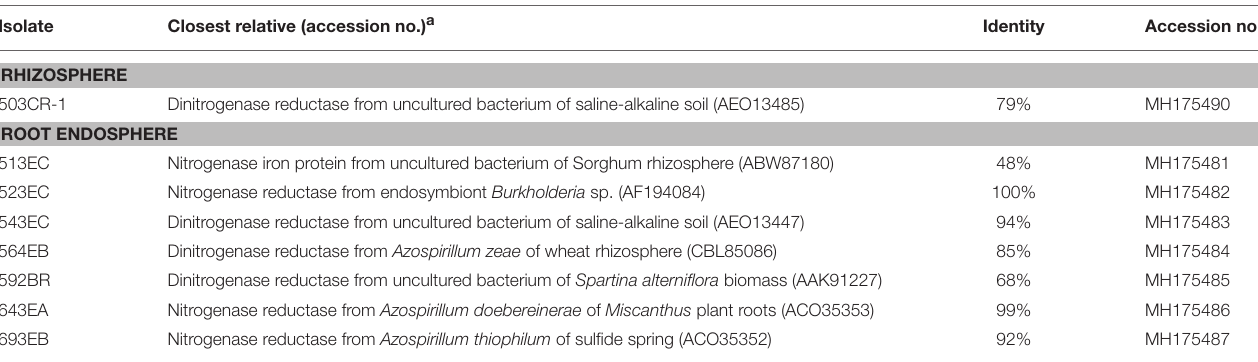
Isolate Closest relative (accession no.)